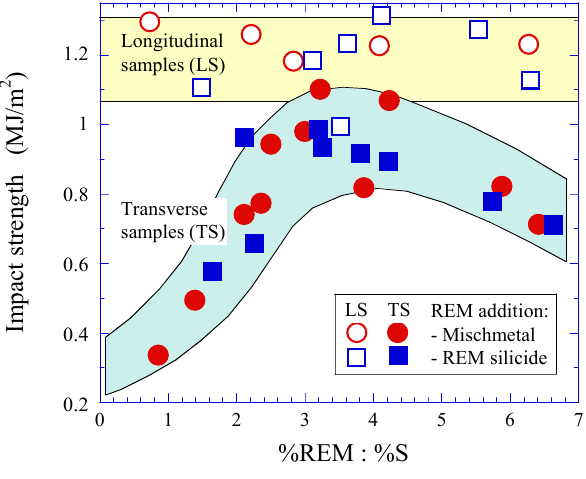
Figure 19. Impact strength in longitudinal (LS) and transverse (TS) samples as a function of the ratio of REM and S contents (in mass-%) in steel with additions of mischmetal or REM silicide